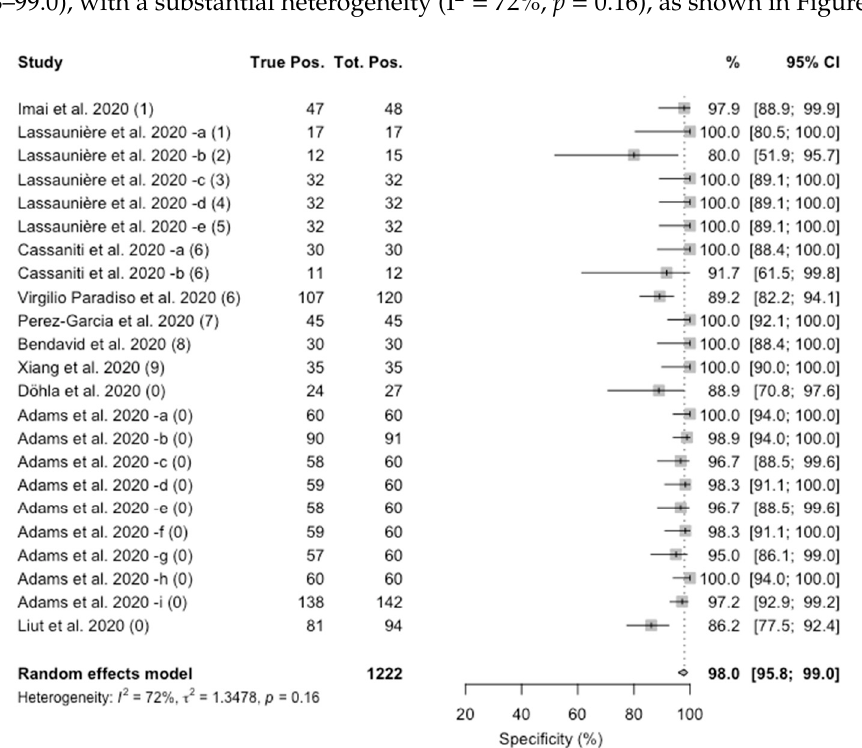
Figure 2. Forest plot representing the estimated pooled specificity of studies on Point-of-Care rapid tests for IgM / IgG antibodies for SARS-CoV-2. Mean specificity is 98.0% (95%CI 95.8–99.0). Notes on manufacturers of assessed kits: (1) Artron laboratories; (2) Acro Biotech; (3) AutoBio Diagnostics; (4) Dynamiker; (5) CTK Biotech; (6) VivaDiag; (7) AllTest Biotech; (8) Premier biotech; (9) Zhuhai Livzon Diagnostics; (0) undisclosed manufacturer.